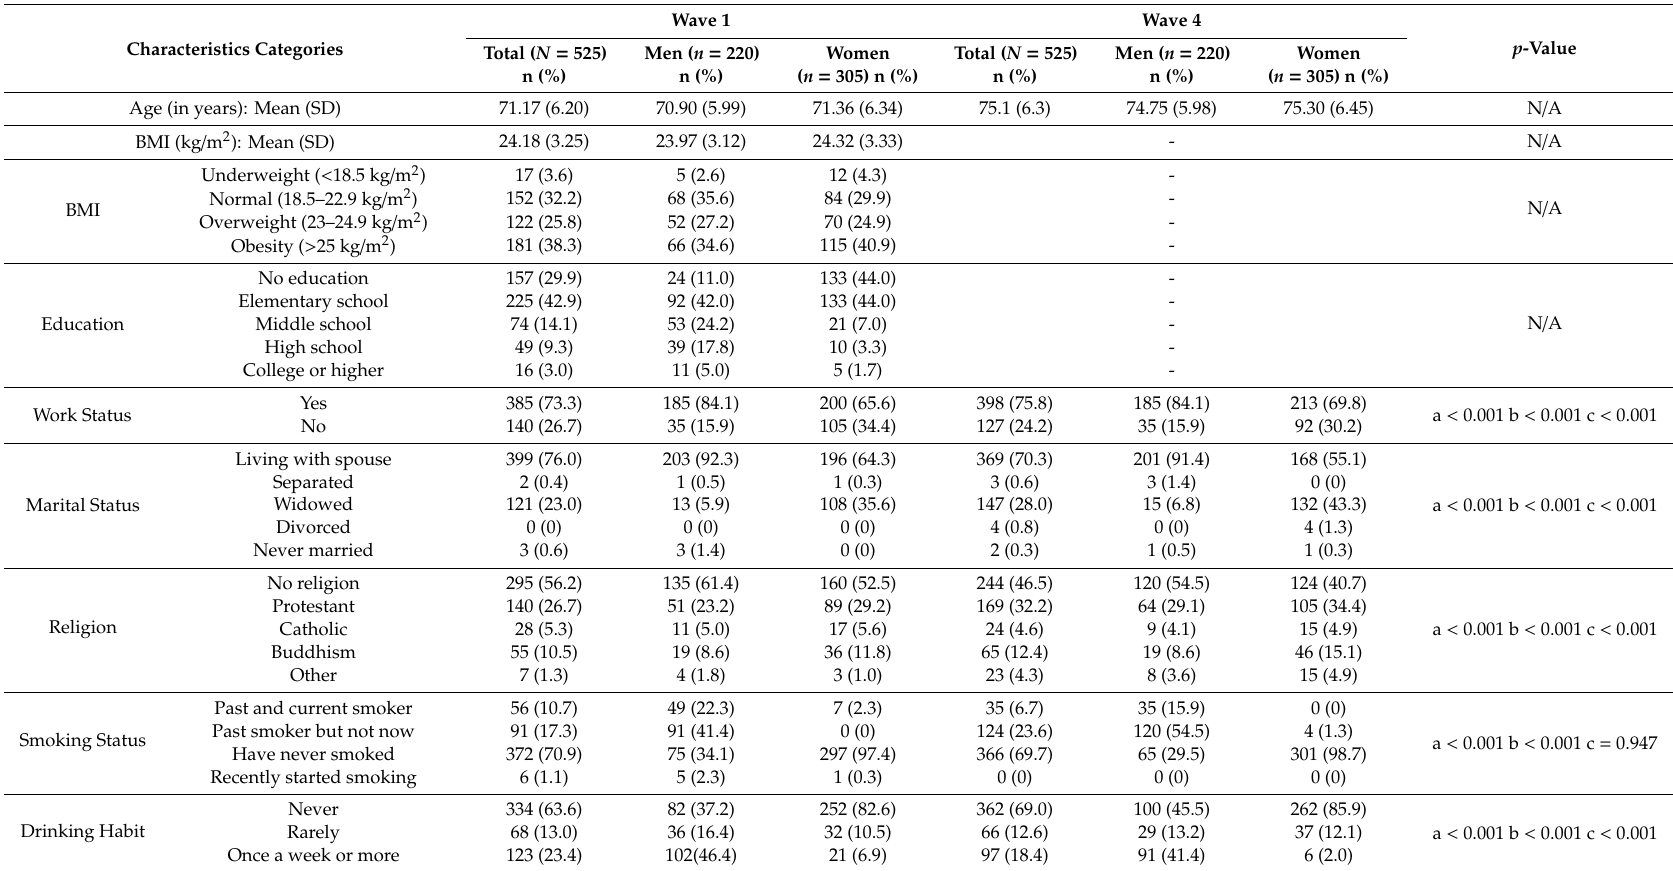
Table 1. Characteristics of the Sample ( N =